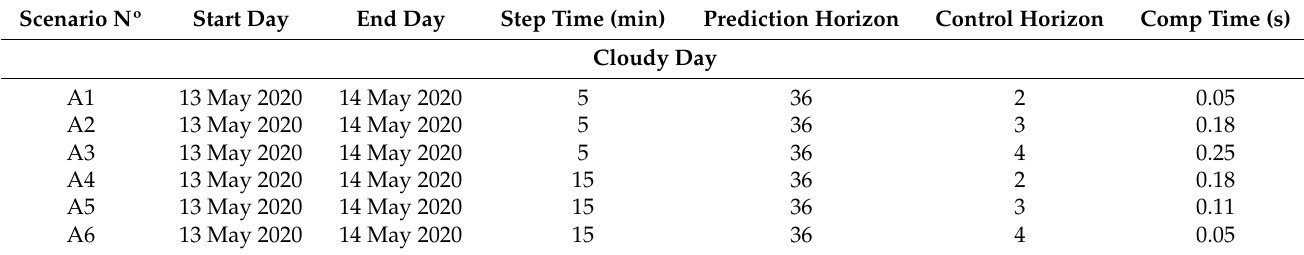
Table 3. Analysis 2-Scenario